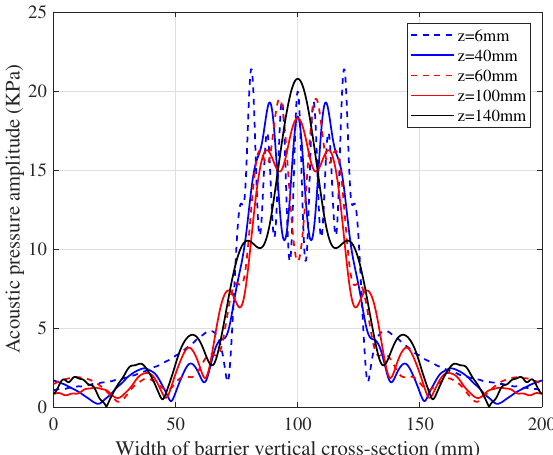
Figure 6. Line acoustic pressure distribution on the vertical cross-section of the barrier.